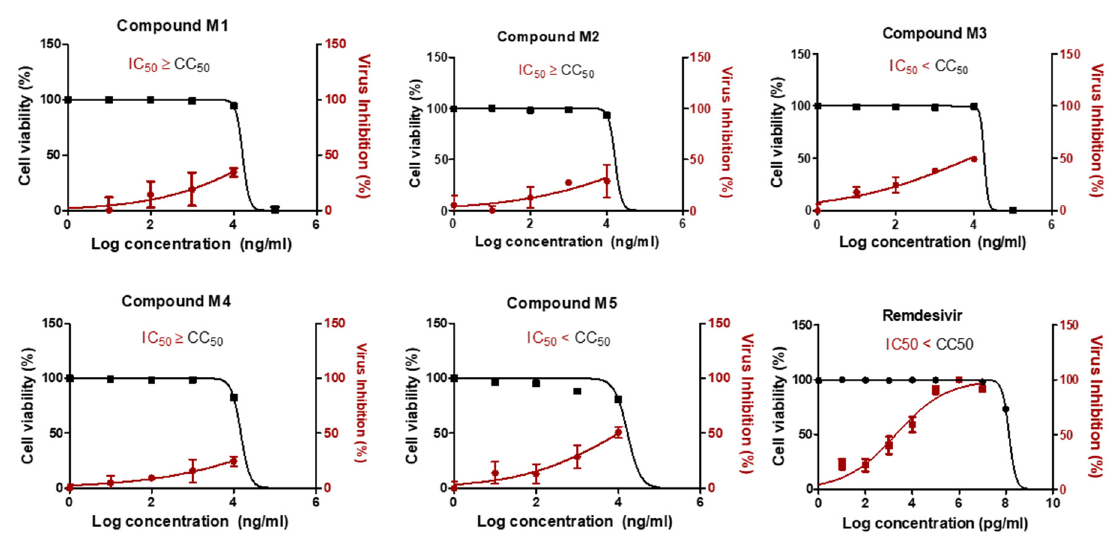
Figure 4. In vitro antiviral activity of compounds M1–M5 . The antiviral activities of the compounds were screened on NRC-03-nhCoV strain (Accession # EPI_ISL_430820) co-cultured with Vero-E6 cells. To determine the most effective and safer compounds, selectivity index (SI) was measured, and the compounds with high SI were selected. Values of inhibitory concentration 50% (IC 50 ) on viral cells and cytotoxic concentration 50% (CC 50 ) on Vero cells were calculated using nonlinear regression analysis by plotting log inhibitor concentration versus normalized response (variable slope). The data display the mean of cell viability percentage ± SEM of 4 replicas.